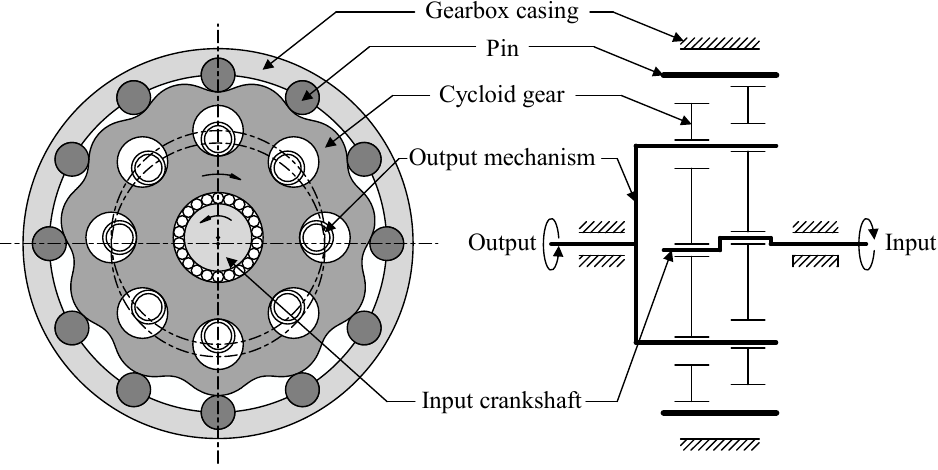
Figure 1. Typical structure of cycloid-pin gear reducer .